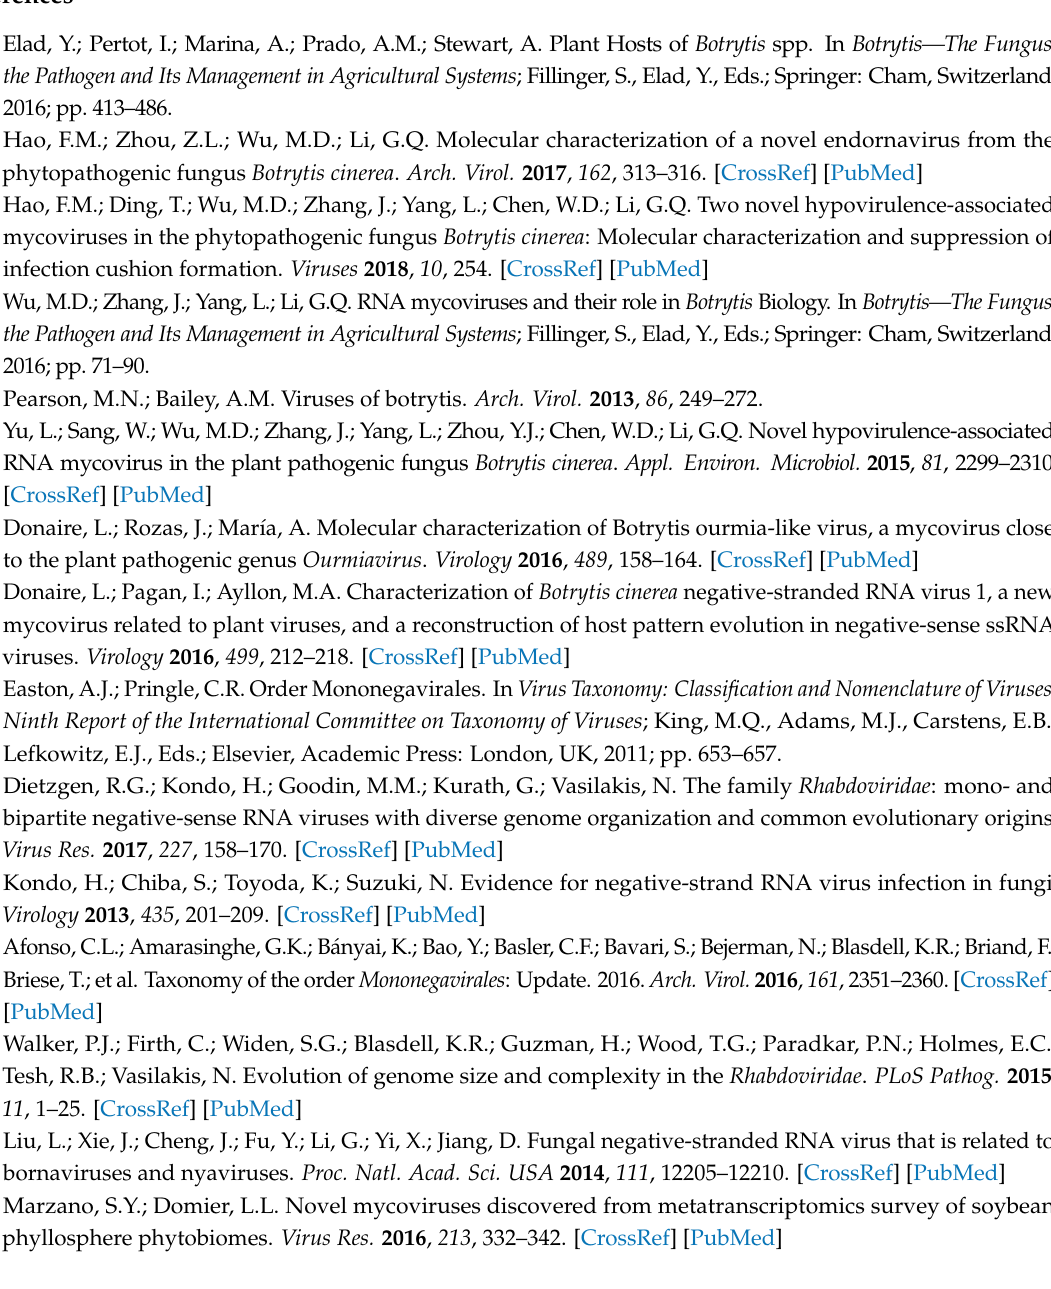
Table S1: Oligonucleotide primers/adaptor used in this study. Figure S1: Schematic representation of the strategy used for full cDNA sequence cloning of Botrytis cinerea mymonavirus 1 (BcMyV1). Figure S2: Transmembrane domains prediction for ORF1 encoded polypeptide L of